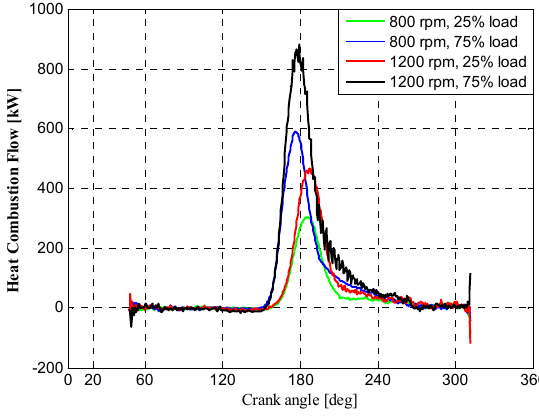
Figure 14. Heat combustion flow at four working conditions.